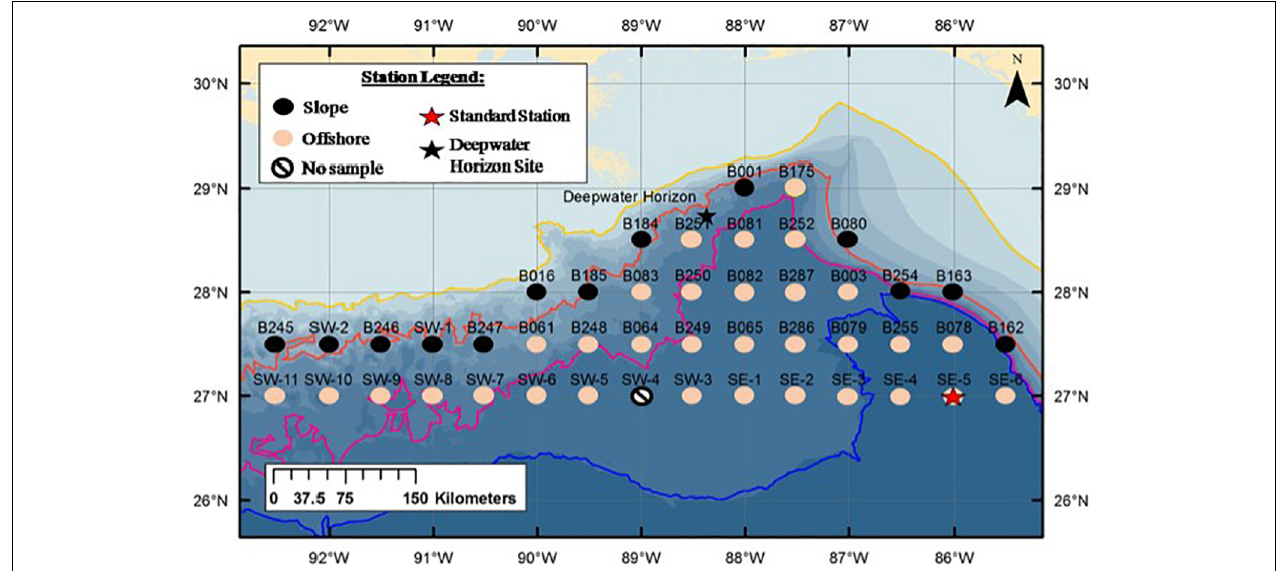
FIGURE 1 | Sampling stations of the M/V Meg Skansi cruise from April to June showing slope and offshore station divisions. The orange line is the 1000 m isobath. Stations on or to the landward size of this line (black circles) were considered slope stations; stations on the seaward side of this line (pink circles) were considered offshore stations. Black star indicates Deepwater Horizon oil rig. Red star indicates Standard Station (Kinsey and Hopkins, 1994). Figure is from Burdett et al. (2017), used with permission from the Bulletin of Marine